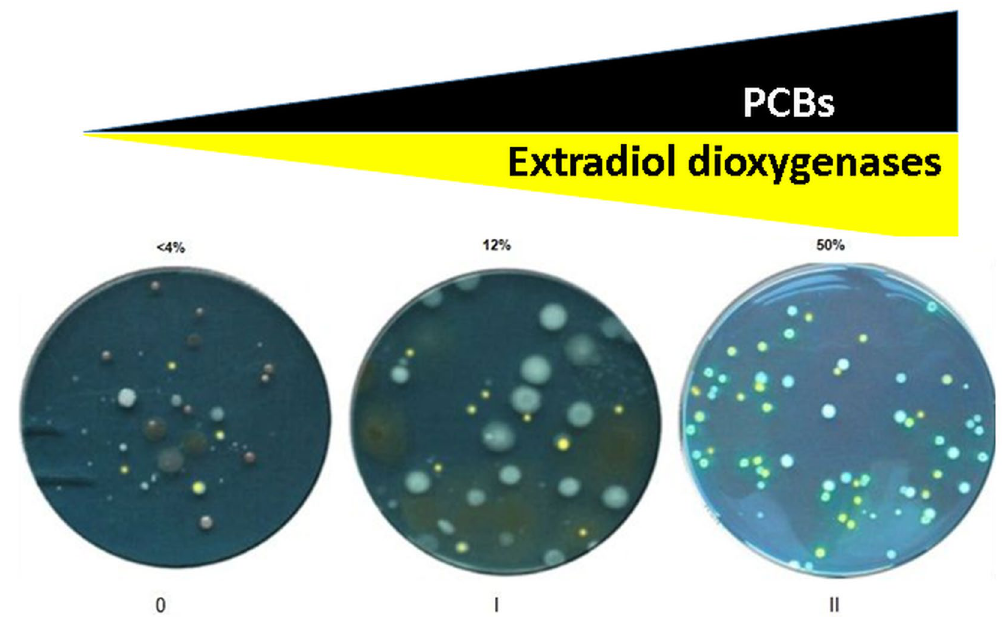
Figure 3. Increasing the level of PCBs contaminants select for strains with extradiol dioxygenase activity from the three soil sites, (0) clean soil, (I) slightly contaminated, and (II) highly